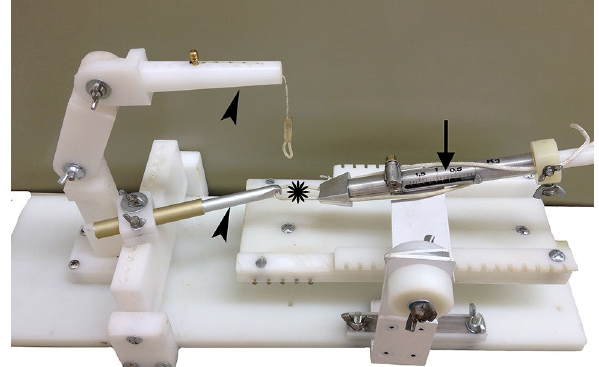
Figure 5. System designed for performing the ischemia. The leg is placed into the loop of the tourniquet (asterisk), adjusting the tensile force with the dynamometer (arrow). The tourniquet is fitted at the top of the thigh with the help of a support arm (lower arrowhead), while the other support arm (upper arrowhead) pulls on the end of the leg.